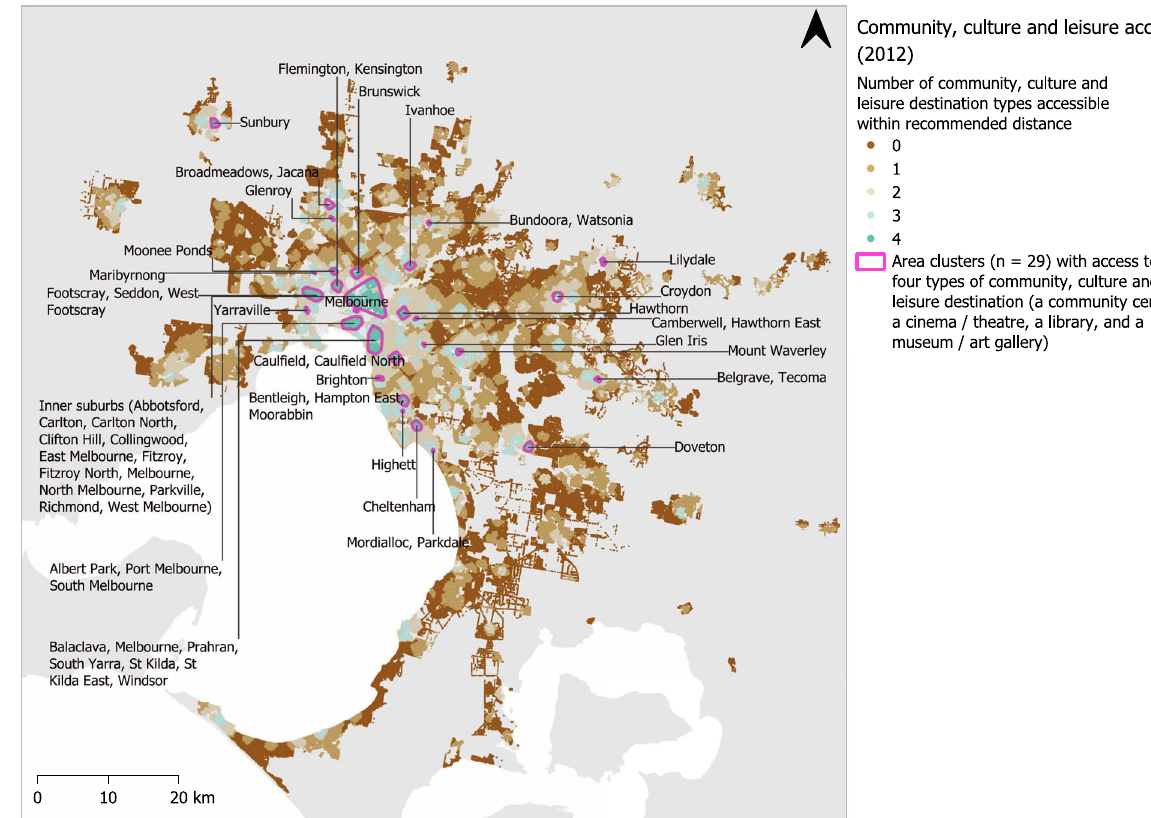
Fig. 2 Spatial distribution of community, culture and leisure access. Spatial distribution of community, culture and leisure access, with annotated convex hull clusters of address points with full access to community, culture and leisure destination types within recommended distances. The Australian continental digital boundary for 2011 was sourced from the Australian Bureau of Statistics under CC BY 4.0 licence as per the data availability